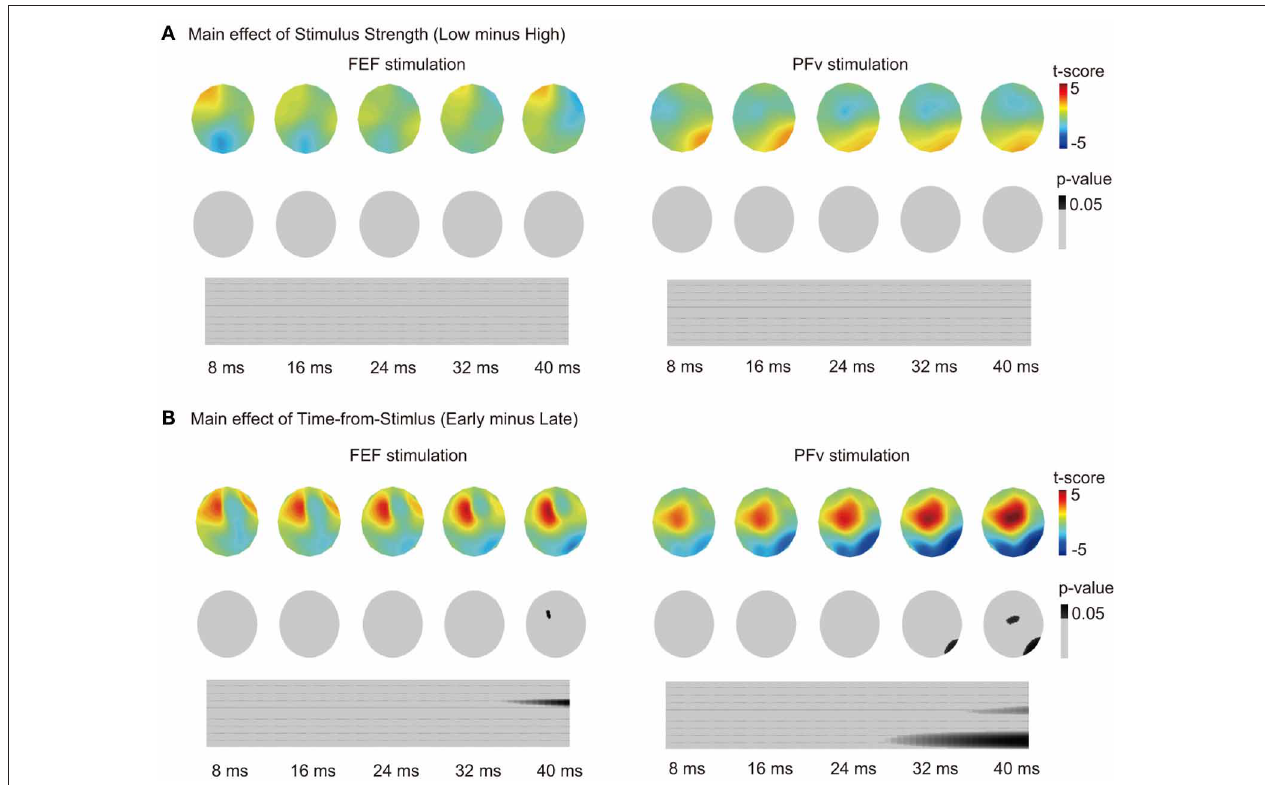
FIGURE 3 | (A) Main effect of motion coherence on TMS-EPs. Same format as in Figure 2C . (B) Main effect of Time-from-Stimulus on TMS-EPs. Same format as in Figure 2C .